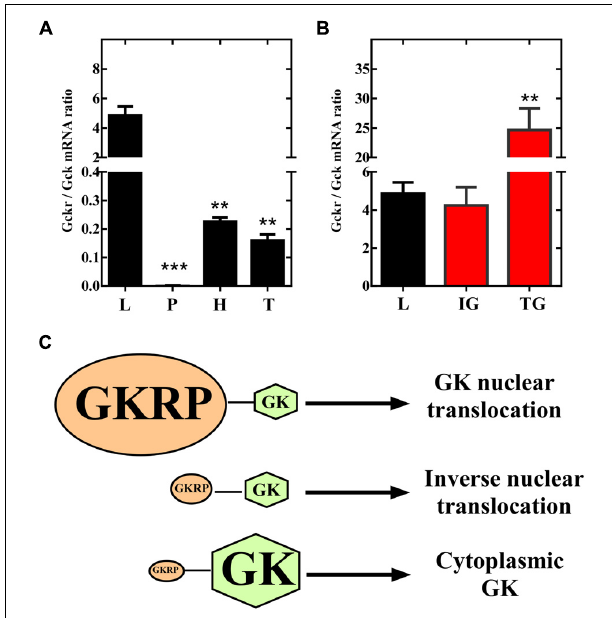
FIGURE 5 | Relative expression of Gckr and Gck in different tissues. (A) Expression levels for Gckr and Gck were measured by qPCR and expression ratios were calculated for liver (L), pancreas (P), hypothalamus (H), and tanycytes (T). (B) Expression ratios for ad-GKRP transduced insulinoma (IG), and ad-GKRP tranduced tanycytes (TG). (C) Model to describe translocation dynamics determined by the ratio of expression between Gckr and Gck. When GKRP is in excess, in relation to GK, nuclear translocation is found at low glucose concentrations (as observed in hepatocytes). When GKRP is less expressed, in relation to GK, nuclear translocation is observed at high glucose concentrations (as observed in tanycytes). Statistical T -test, ∗∗ p -value < 0.01, ∗∗∗ p -value <